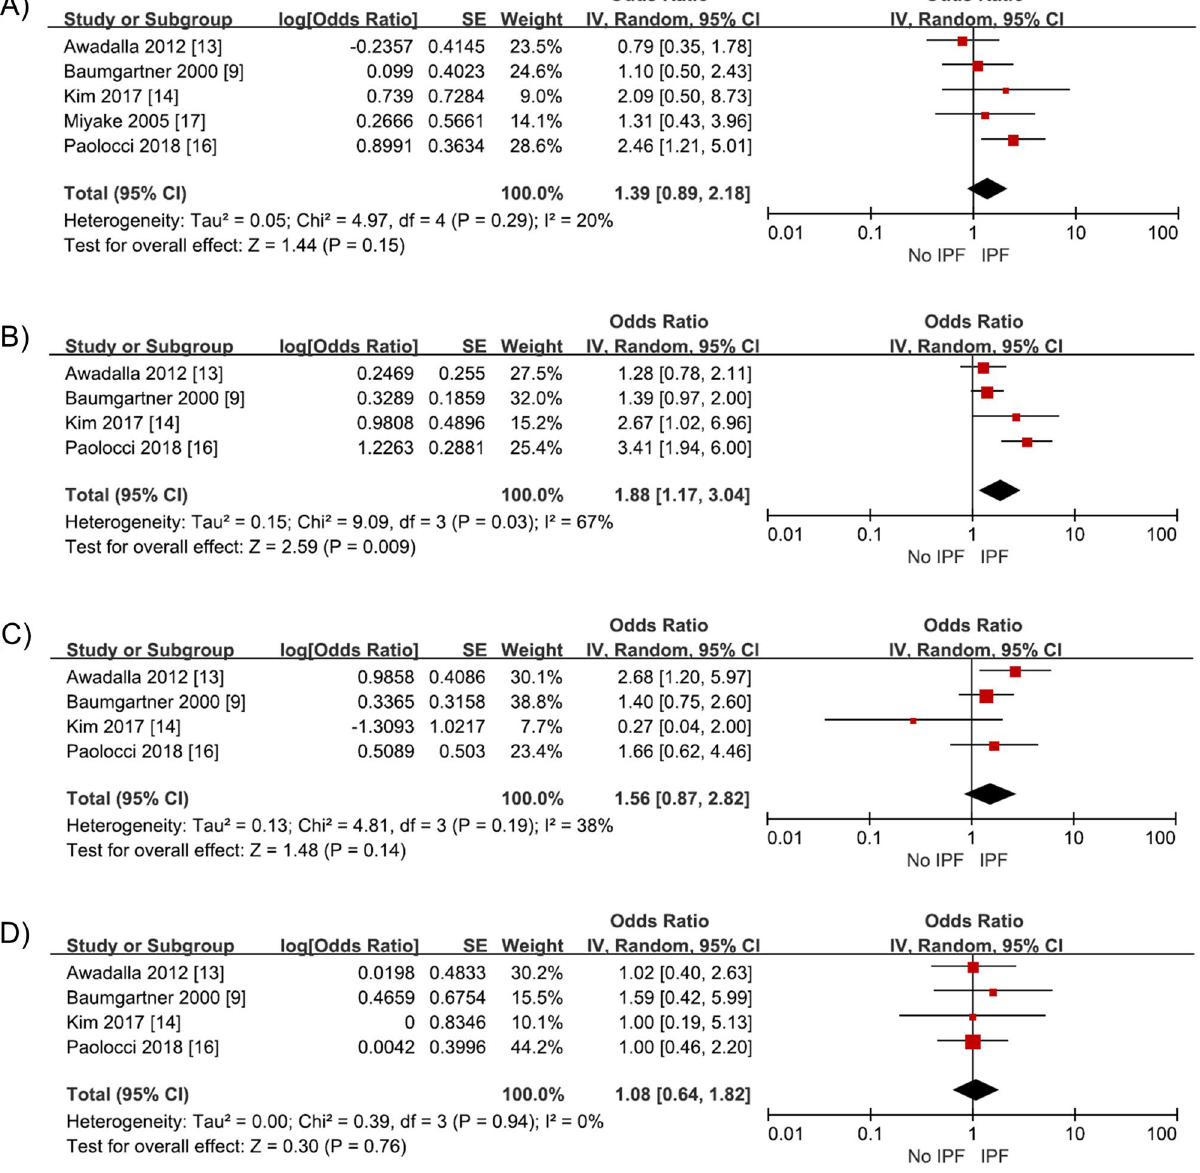
Figure 3. Risk of IPF in occupation compared to non-IPF controls. ( A ) building construction and demolition workers, ( B ) farming or agriculture workers, ( C ) carpentry and wood workers, and ( D ) textile making workers.